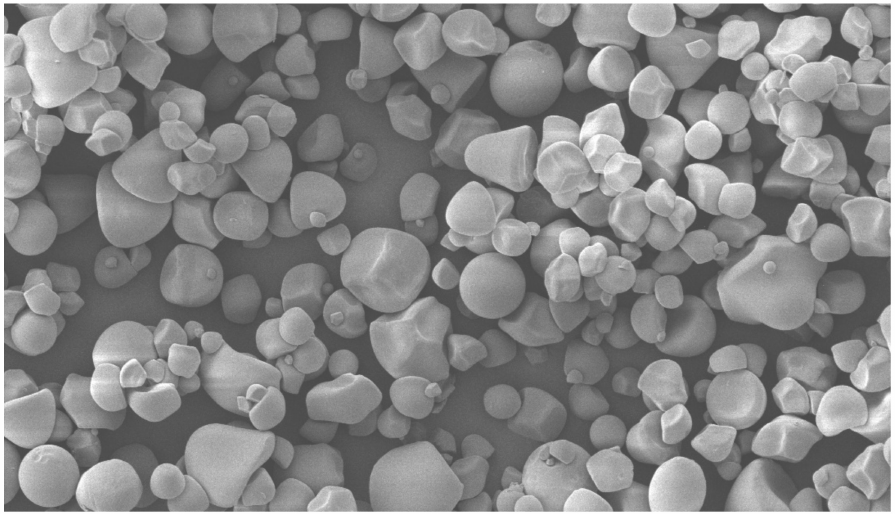
Figure 6. Scanning electron microscopy (500 × magnification) of sweet potato starch granules. Source: personal